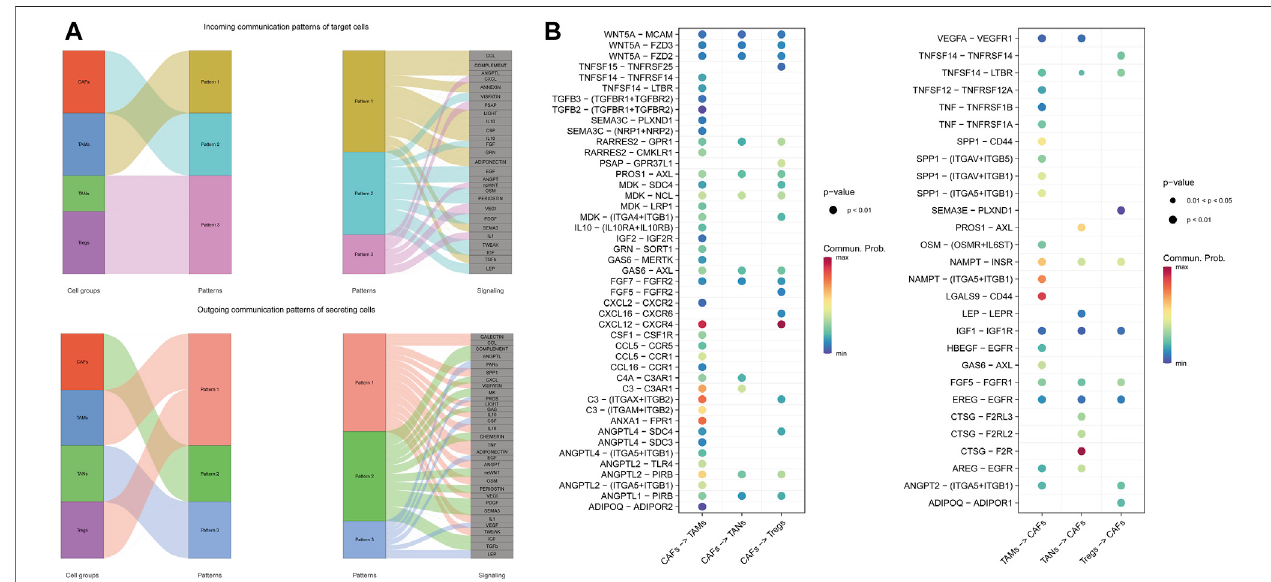
FIGURE 5 | The intracellular communication network of immunosuppressive cells. (A) Incoming (upper panel) and outgoing (lower panel) communication patterns of target and secreting cells, respectively. (B) All signi fi cant LR interactions between CAFs and the immunosuppressive cells.